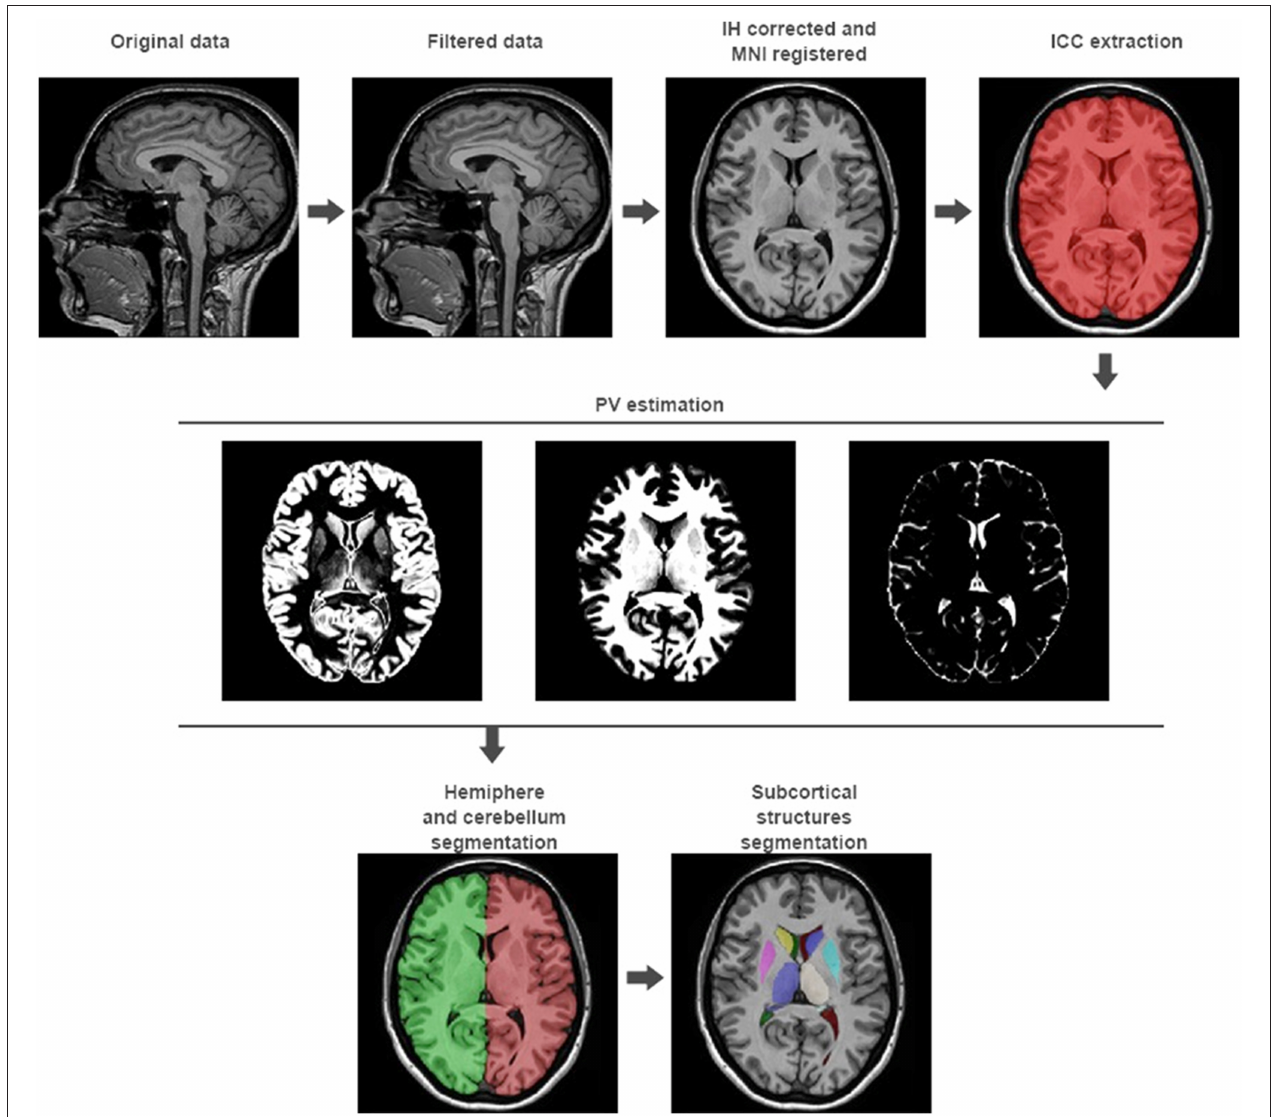
FIGURE 1 | volBrain processing pipeline. In the first row, the preprocessing of any new subject is presented. It consists in a non-local noise reduction filter, inhomogeneity correction, MNI space registration, intensity normalization, and ICC extraction. In the second row, the result of the global tissue estimation (GM, WM, and CSF) is shown. In the third row, the result of the macrostructures and subcortical structures segmentation is